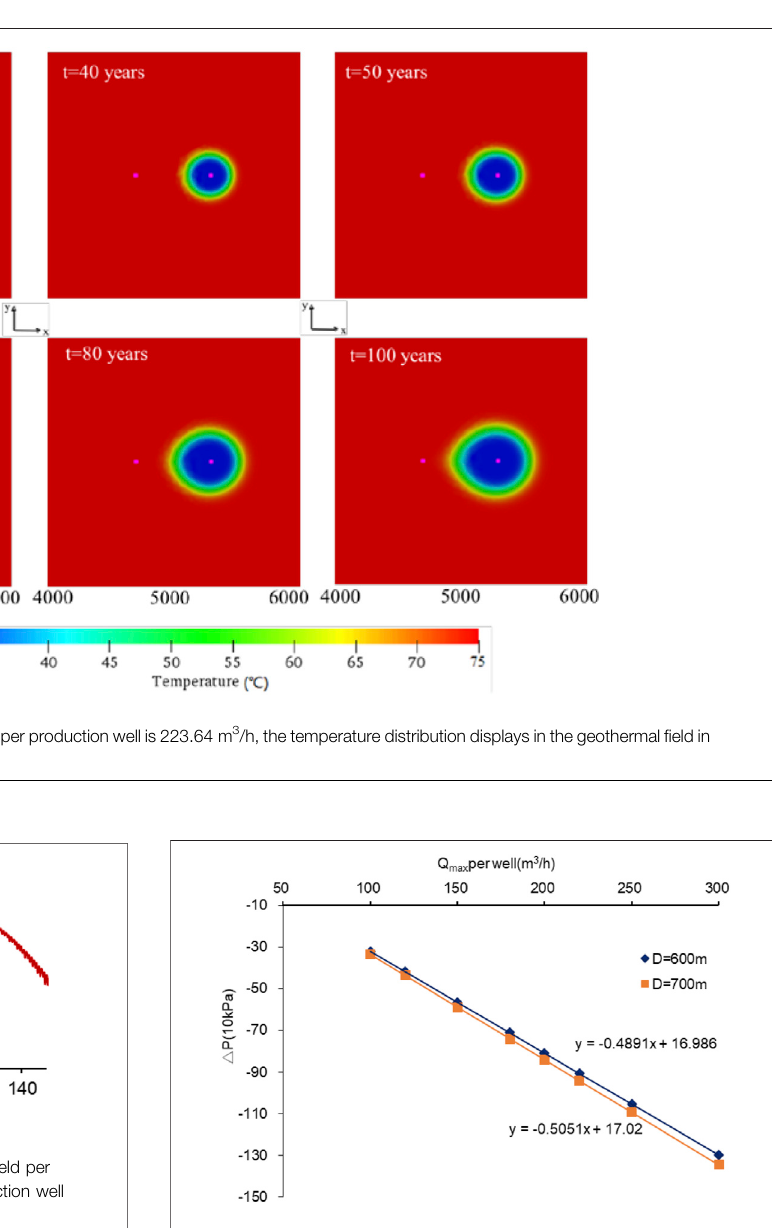
Frontiers in Earth Science |